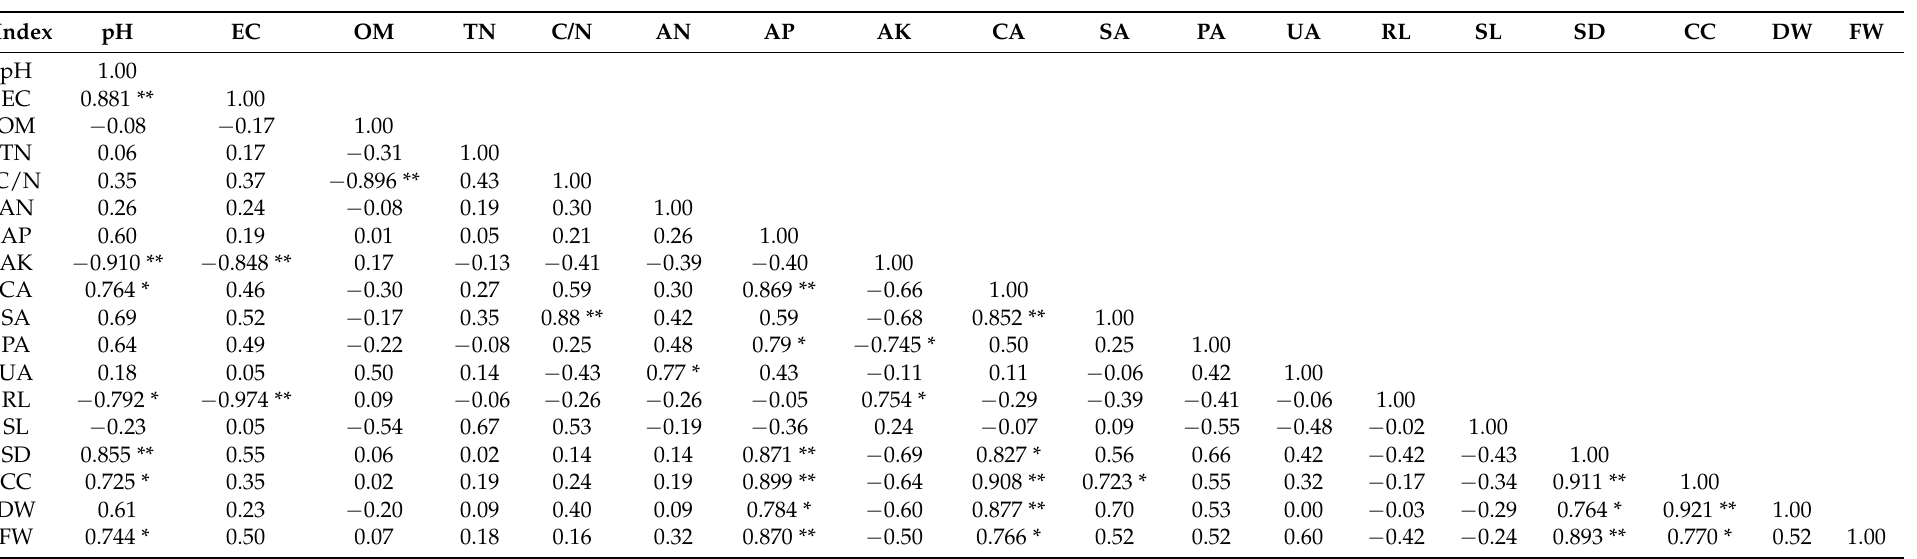
Table 3. Pearson’s correlations (r) among substrate pH, electrical conductivity (EC), chemical properties, enzymatic activities, and plant